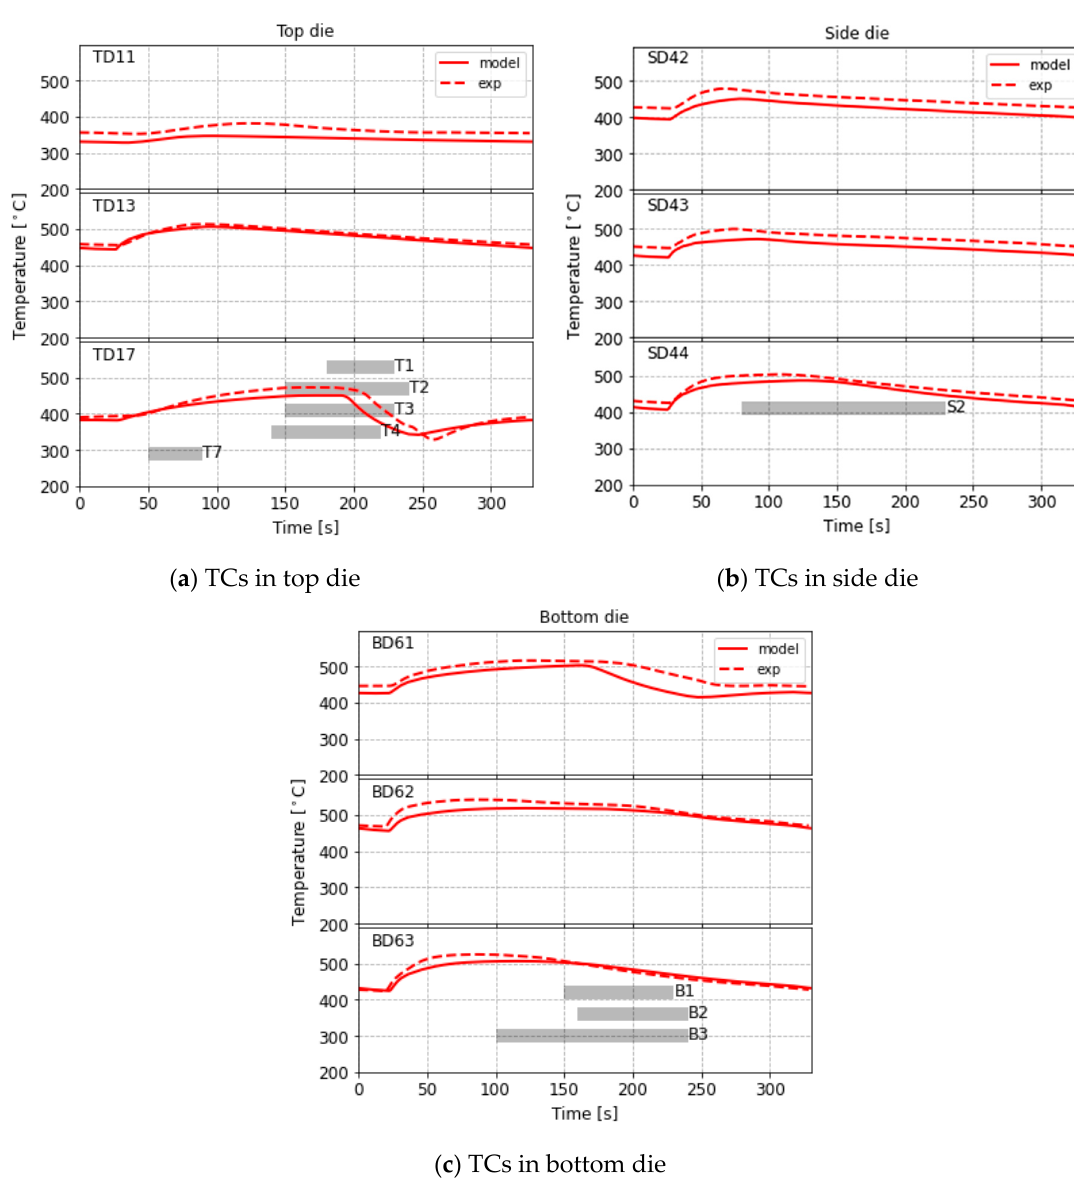
Figure 8. Temperature comparison between the model and measured data for the production process condition in Die-A.